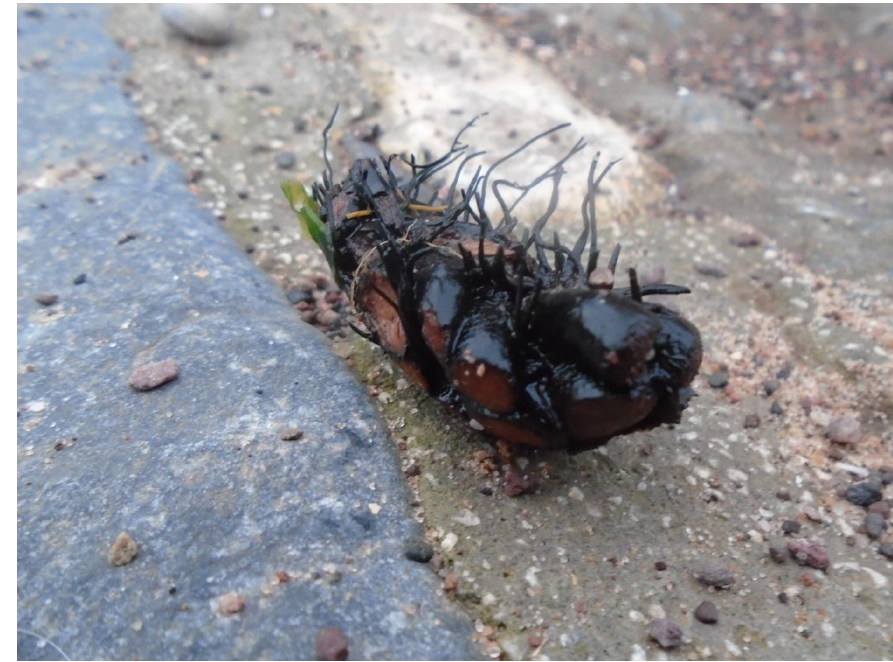
Figure 33. Enigmatic traveller.